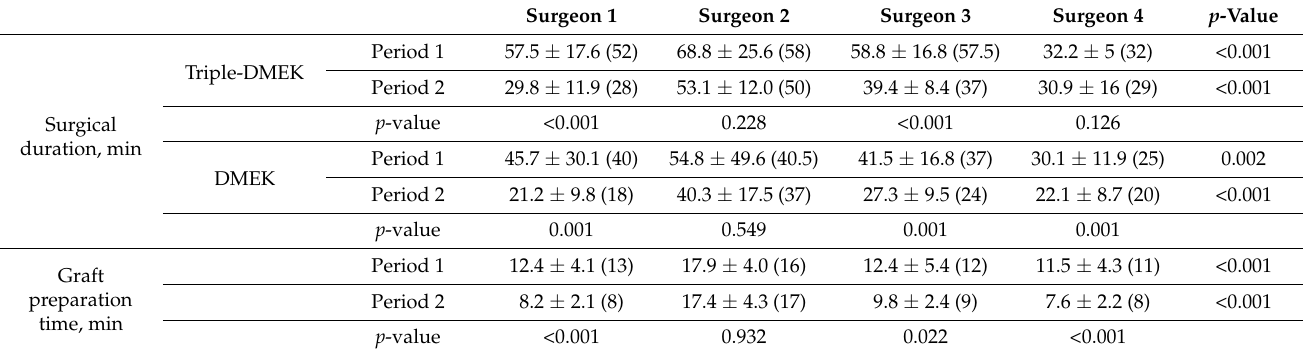
Table 2. Surgical data.